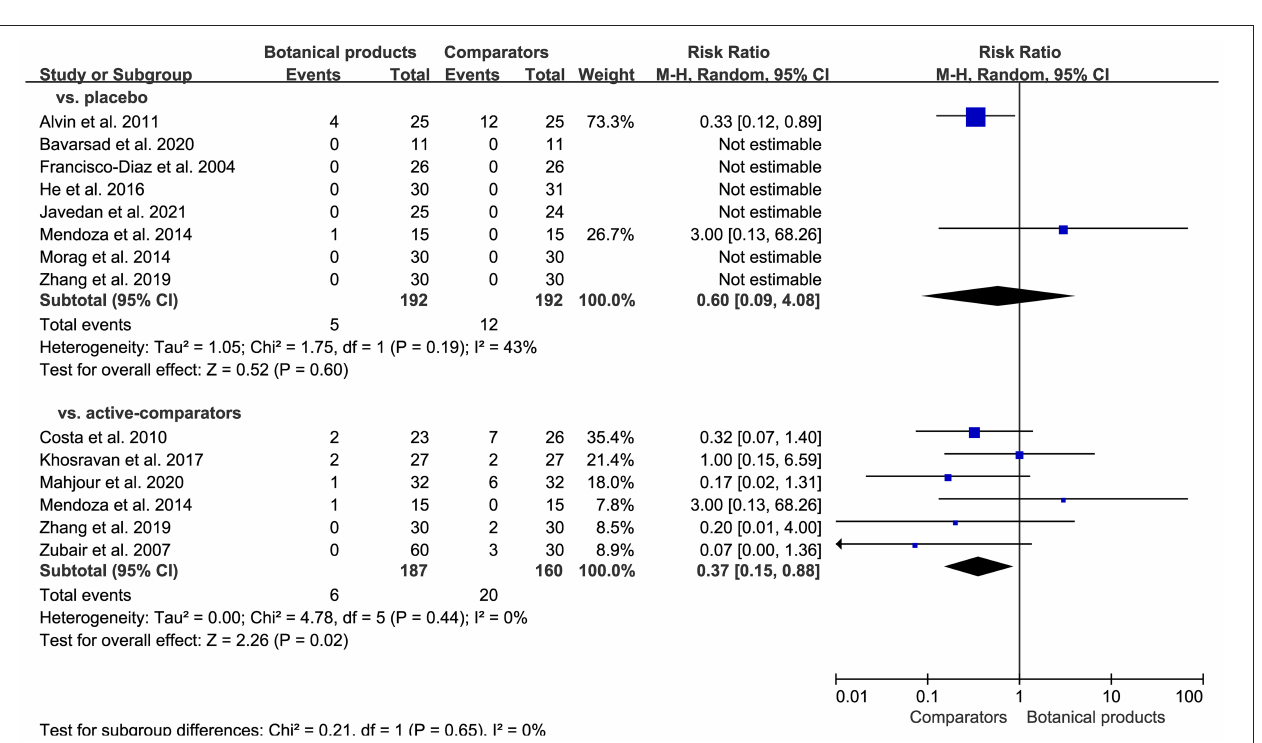
FIGURE 7 | Forest plot depicting the risk ratio (RR) for safety outcome in RCTs investigating the efficacy of botanical products. Subgroup analysis was stratified according to comparators.